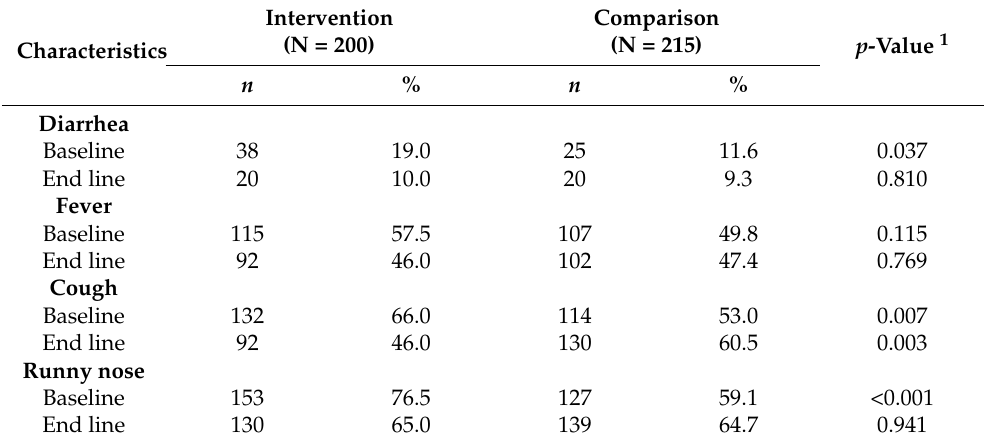
Table 3. Child morbidity at baseline and end line, by treatment